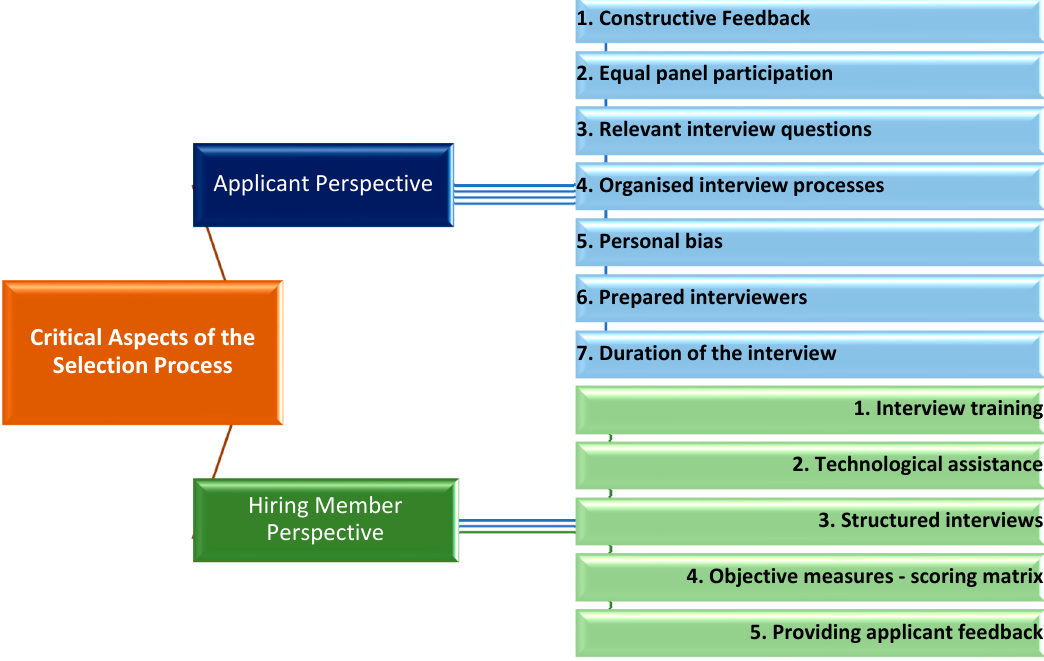
Figure 17. Critical Aspects of the employee selection process.